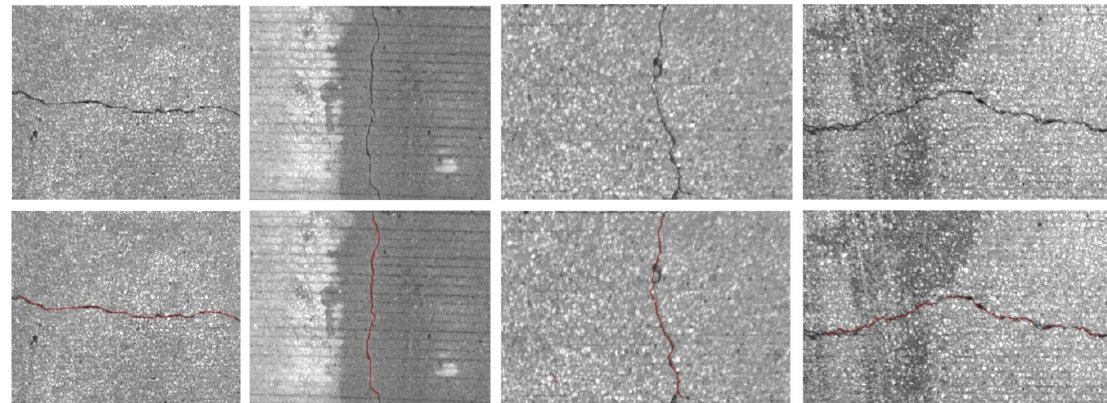
Figure 14. Detected crack pixels and generated crack segments: ( a ) input image, ( b ) detected crack pixels: blue colored circles represent crack pixels in a different direction than the green colored circles of crack pixels in one dominating orientation. The size of circle represents scale of the crack pixel, ( c ) represents initialized and extended crack segments, and ( d ) represents linked crack segments.